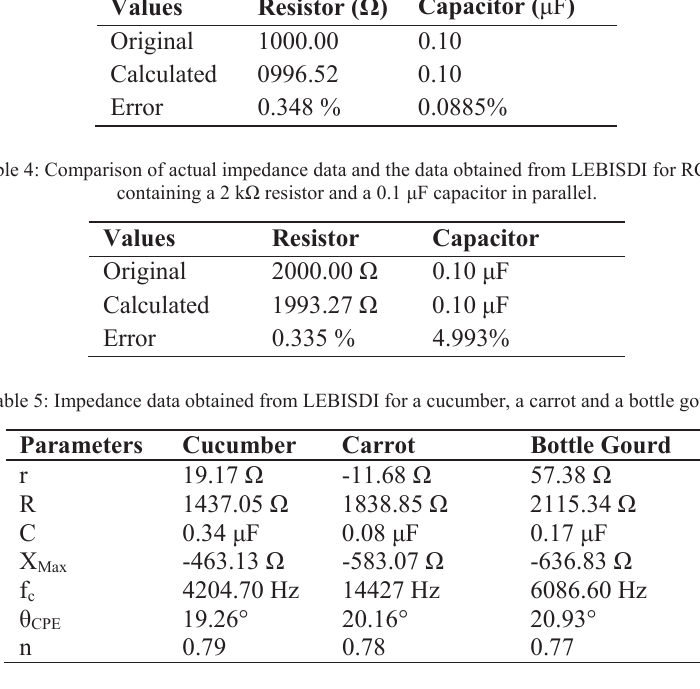
Table 6: Comparison of the impedance parameters obtained from the impedance data estimation in LEBISDI for a green banana before and after